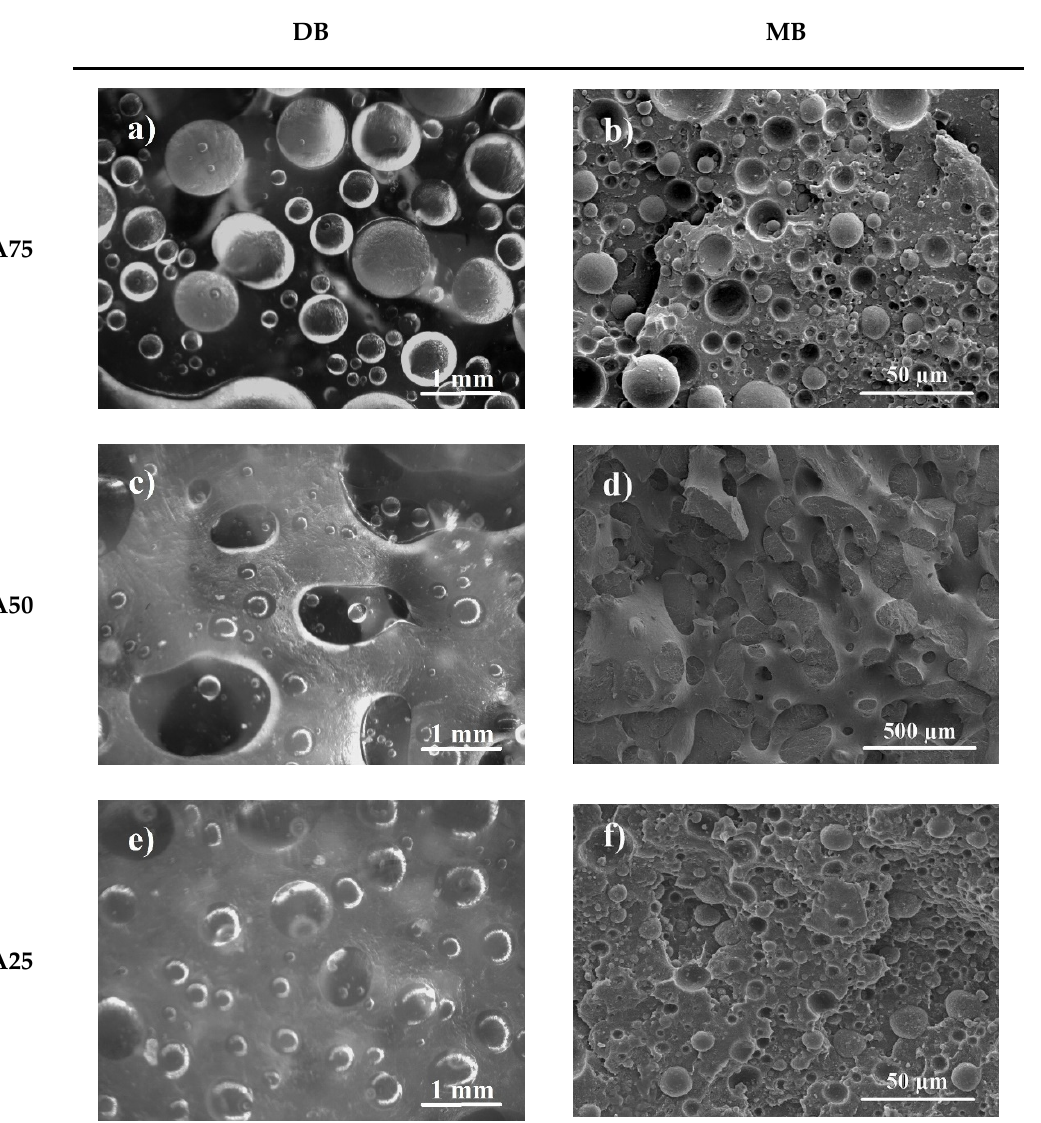
Figure 5. Optical images of the internal surface of rotomolded parts prepared by DB ( left column ) and SEM micrographs of MB cryo-fractured parts ( right column ): ( a , b ) PLA75, ( c , d ) PLA50, and ( e , f ) PLA25.